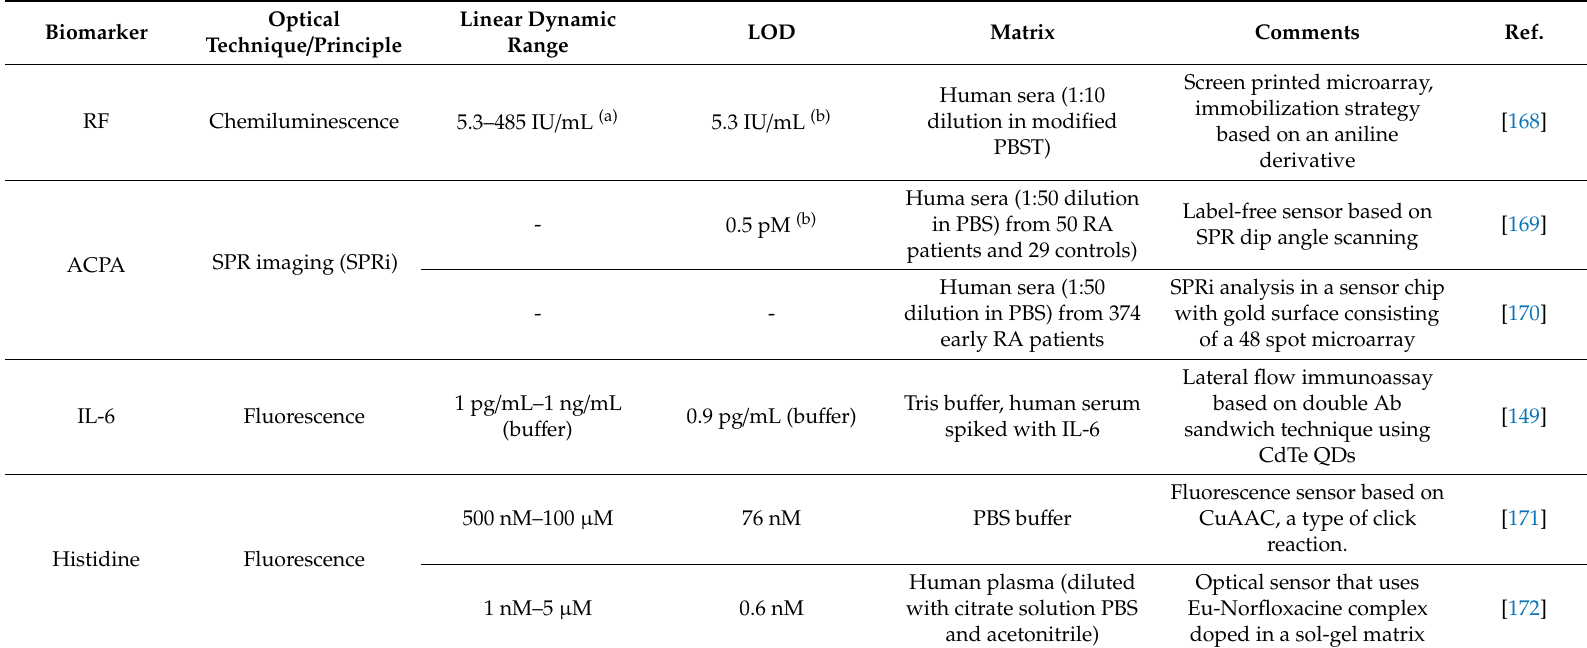
Table 5. Optical biosensors for detection of other RA